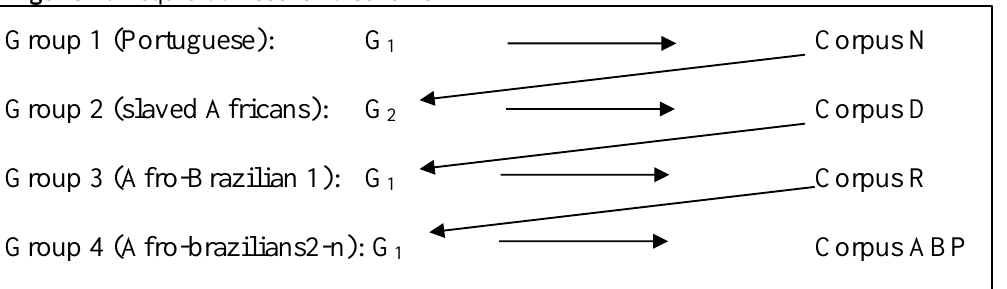
Figure 2. Acquisition scenario